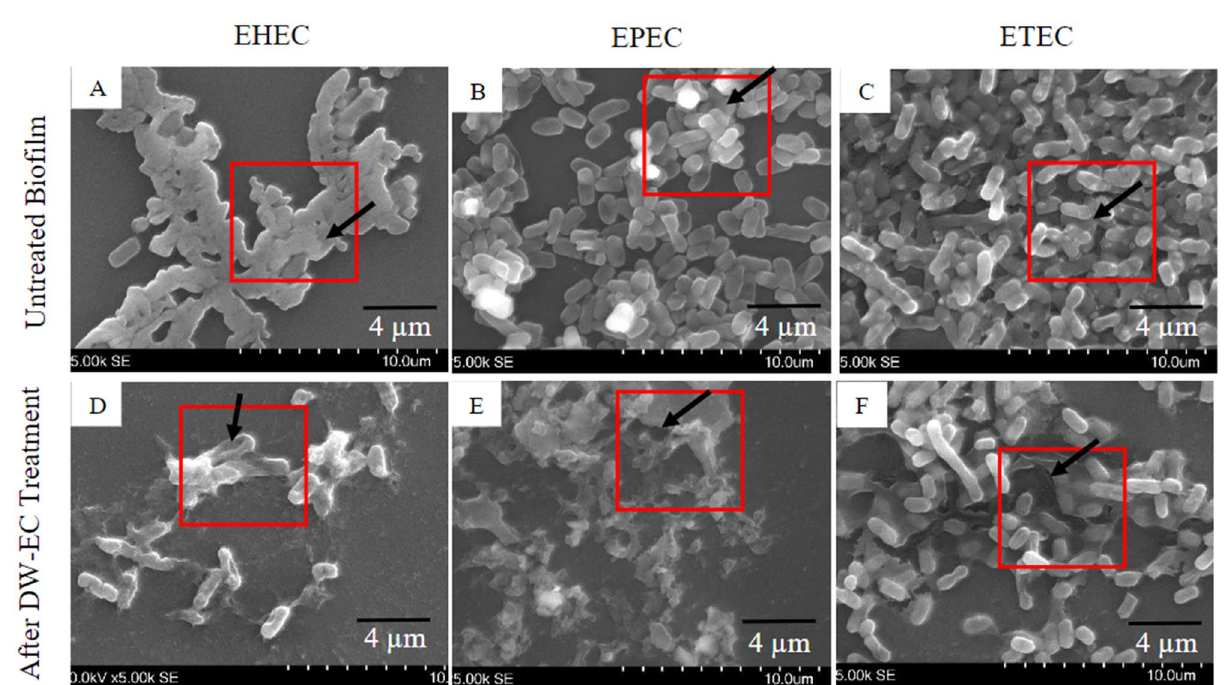
Figure 6. SEM of destruction activity of bacteriophage DW-EC against biofilm formed by several pathogenic bacteria: ( A – C ) untreated biofilm and ( D – F ) biofilm treated with DW-EC. Red box shows biofilm pathogens. Black arrows indicate untreated biofilm ( A – C ), disruption of the biofilm ( E , F ), and bacterial cell wall damage ( D ). Magnification: